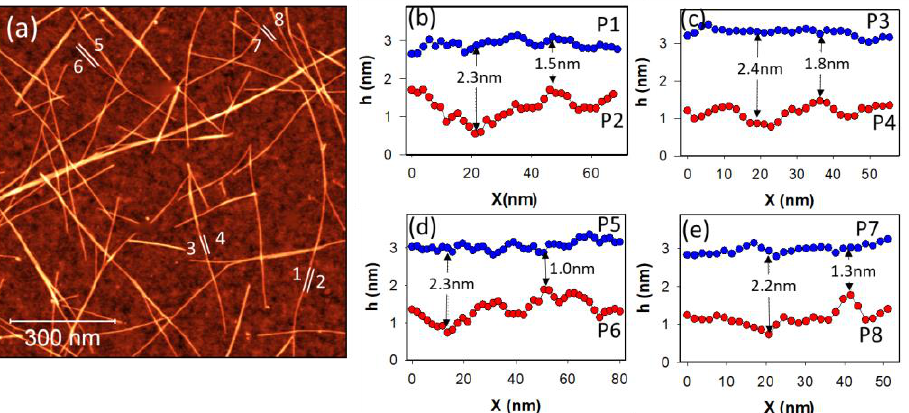
Figure 3. Roughness of profiles on nanotubes and on the SiO 2 substrate. ( a ) A typical 1 × 1 µm 2 AFM image of a network made of PFDD/SWCNTs with numbered white lines, along which the profiles P1–P8 shown in ( b – e ) were extracted. The data points corresponding to profiles along the top of the nanotubes are shown in blue, while adjacent substrate profiles are shown in red. Differences in the height of the substrate and the nanotube at selected points are indicated to illustrate the